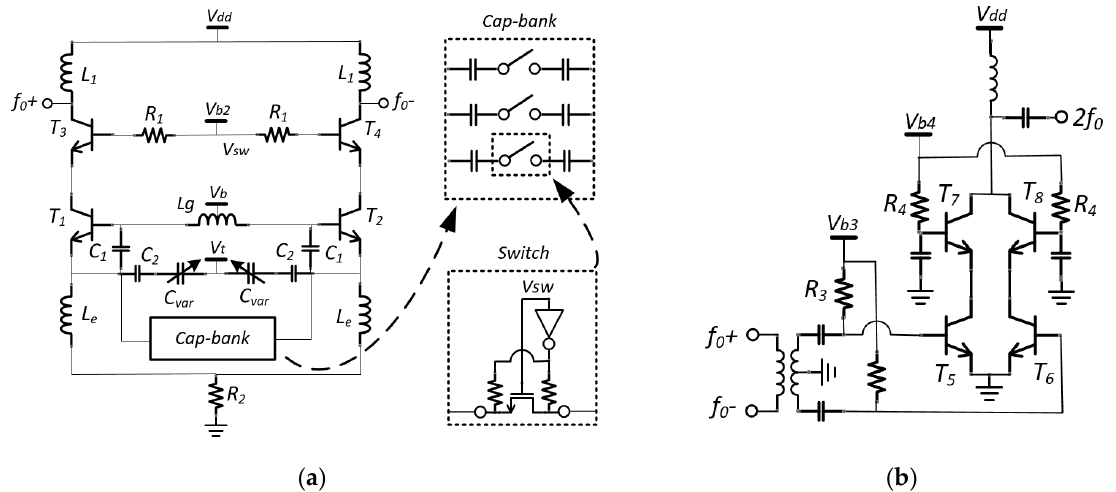
Figure 4. Schematic of ( a ) the Ku-band Colpitts VCO with 3-bit cap-bank; ( b ) the Ka-band doubler.